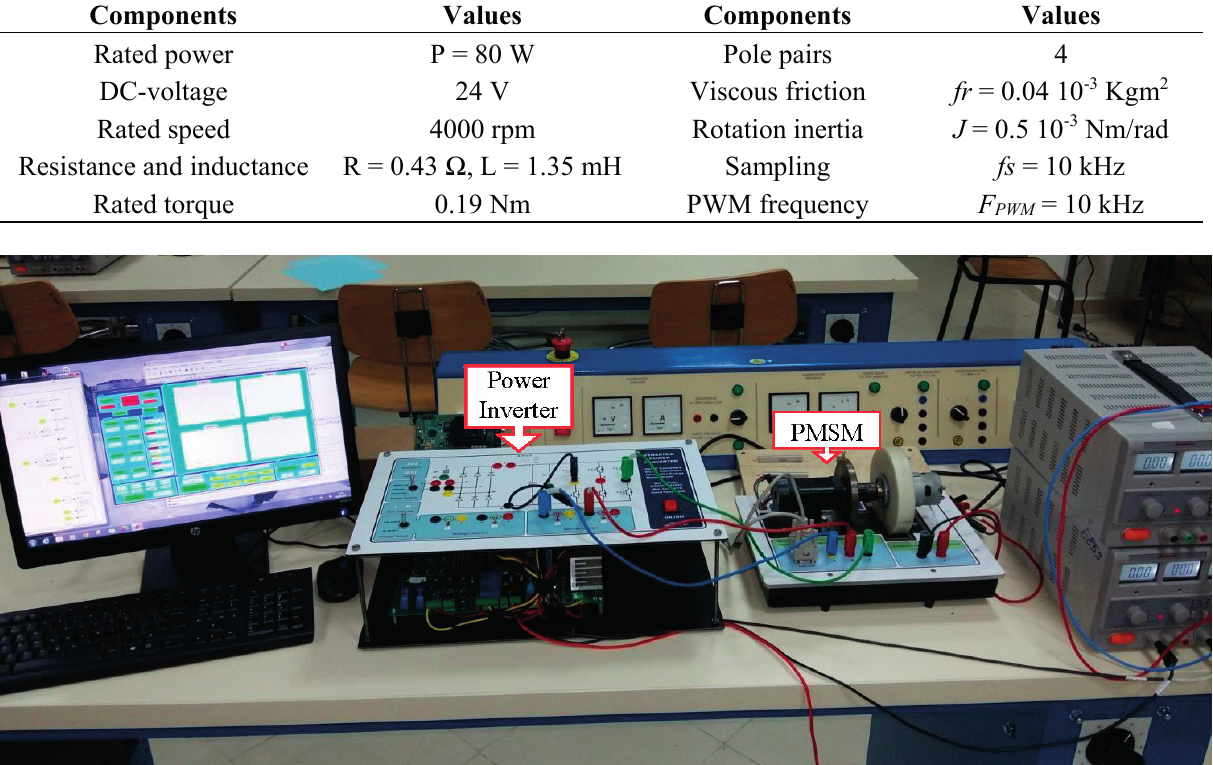
Figure 5. The experimental setup including the 80 W PMSM and power